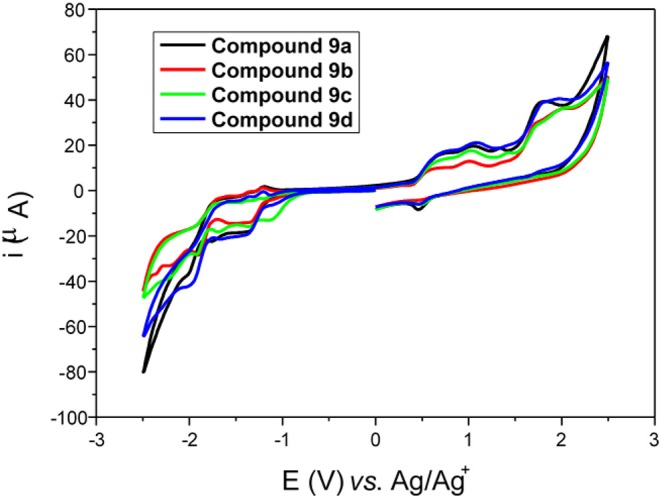
Cyclic voltammogram of compounds 9a–d on a glassy carbon electrode in 0.1 TBAPF6/CH2Cl2 at 100 mV s−1.